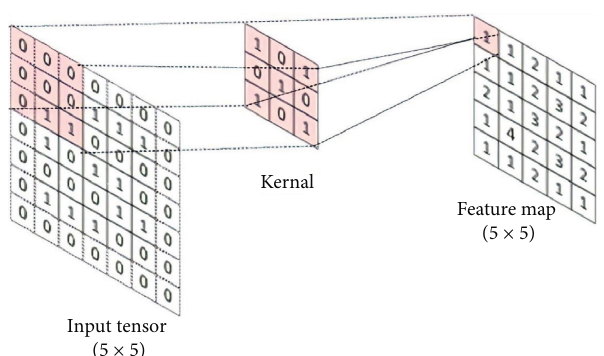
Figure 4: Convolution operation with zero